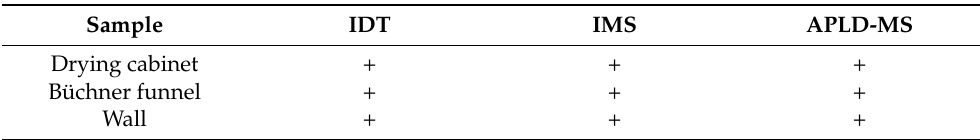
Table 2. Sampling swabs applied at different spots of a clandestine MDMA laboratory. All sampling swabs are examined for MDMA. Plus means positive